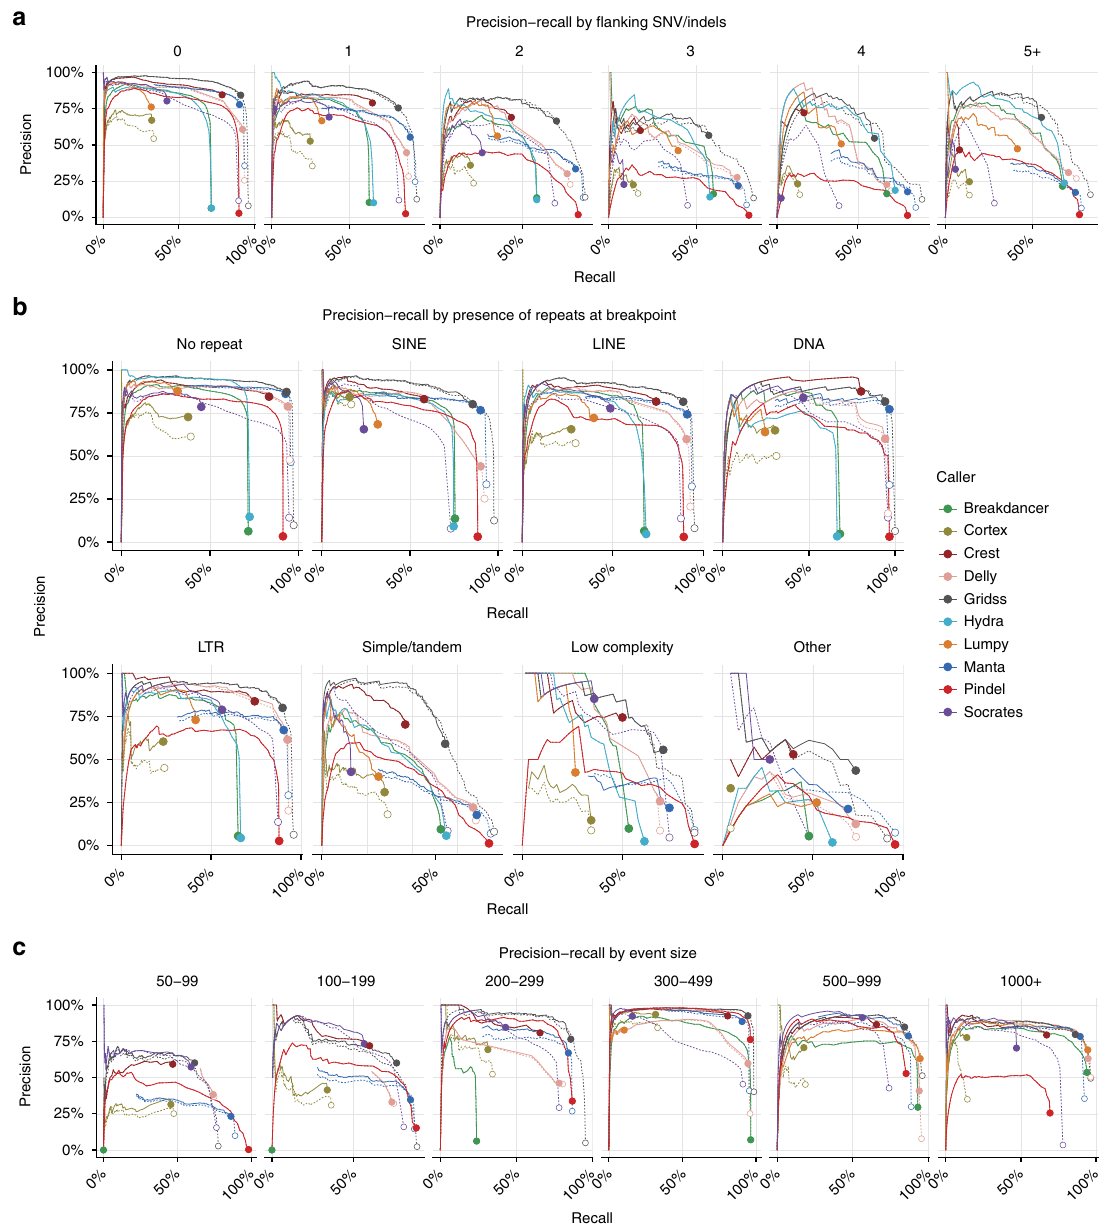
Fig. 2 Callers perform poorly near single-nucleotide variants (SNVs) and indels, near low complexity and simple tandem repeat regions, and in detecting small events. Precision vs. the number of true positives (see Fig. 1) with calls strati fi ed by: a the number of SNVs and indels within 50 bp of the variant breakpoint; b RepeatMasker/Tandem Repeat Finder annotation of breakpoint location. Similar repeat classes have been merged for clarity; c the size of the event. Open circles and dashed lines correspond to including all calls (passed or not); fi lled circles and solid lines correspond to calls with PASS or “ . ” in the VCF FILTER fi eld and are indicate of high-con fi dence